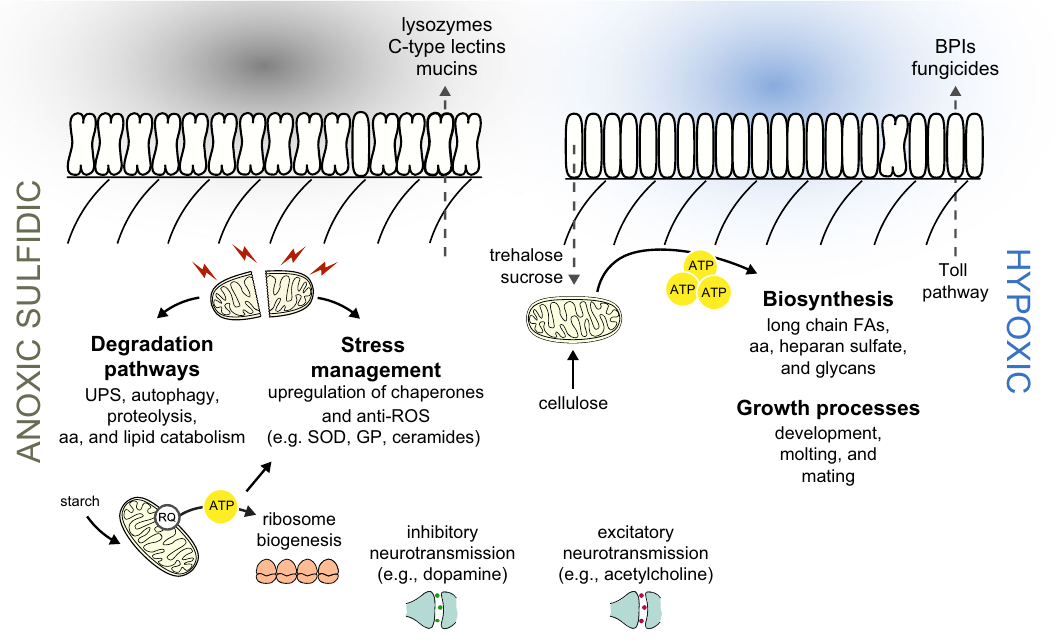
Figure 7. Schematic representation of Laxus oneistus physiology in anoxic or hypoxic conditions. In anoxic sulfidic conditions (left), L. oneistus does not enter suspended animation. Instead, it upregulates the expression of genes mediating inhibitory neurotransmission, involved in symbiosis establishment (e.g., lectins, mucins) and in ribosome biogenesis. Metabolism may be supported by the degradation of starch and by rewiring the electron transfer chain: rhodoquinone (RQ) is used as electron carrier and fumarate as electron acceptor. Moreover, the worm activates degradation pathways (e.g., ubiquitin–proteasome system (UPS), autophagy, and apoptosis) and may anticipate reoxygenation by upregulating superoxide dismutase (SOD) and glutathione peroxidase (GP). In hypoxic conditions (right), instead, L. oneistus appears to use trehalose and cellulose for energy generation, while engaging in costly processes such as development, molting, feeding, and mating. Genes involved in excitatory neurotransmission are also upregulated, together with Toll-like receptors and immune effectors (e.g., fungicides,